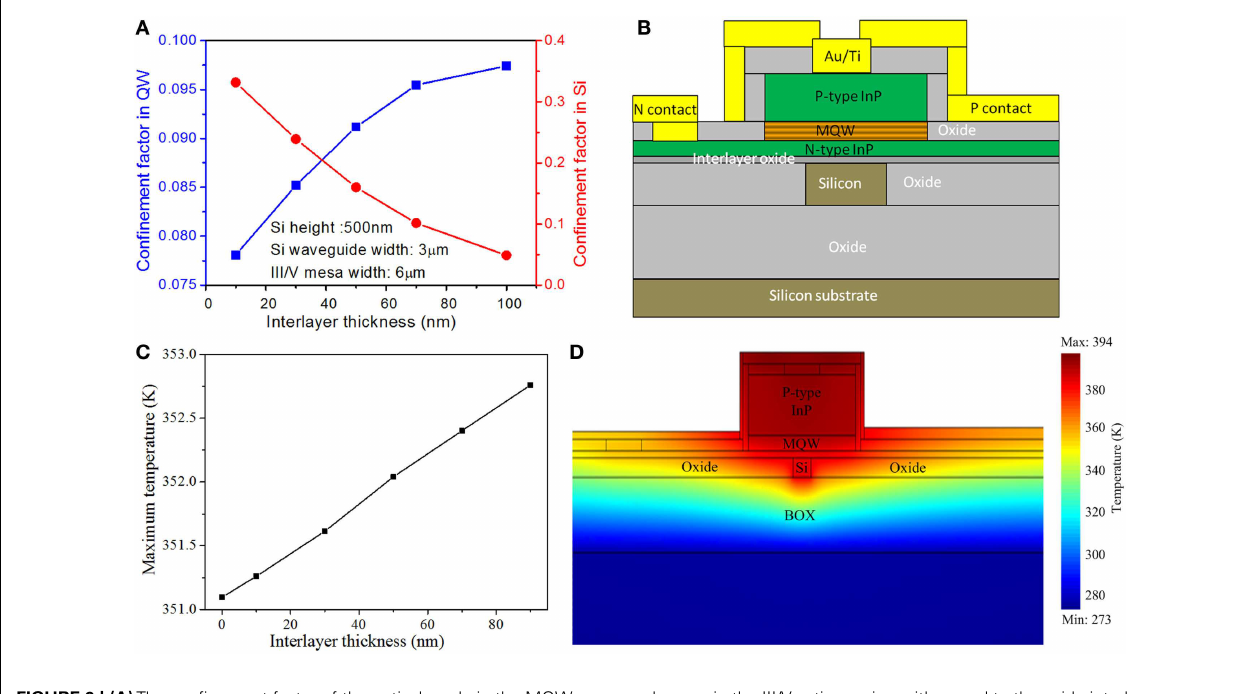
FIGURE 9 | (A) The confinement factor of the optical mode in the MQW and silicon layers, respectively, as a function of the interlayer thickness. (B) The simulation structure of the thermal distribution. (C) The temperature